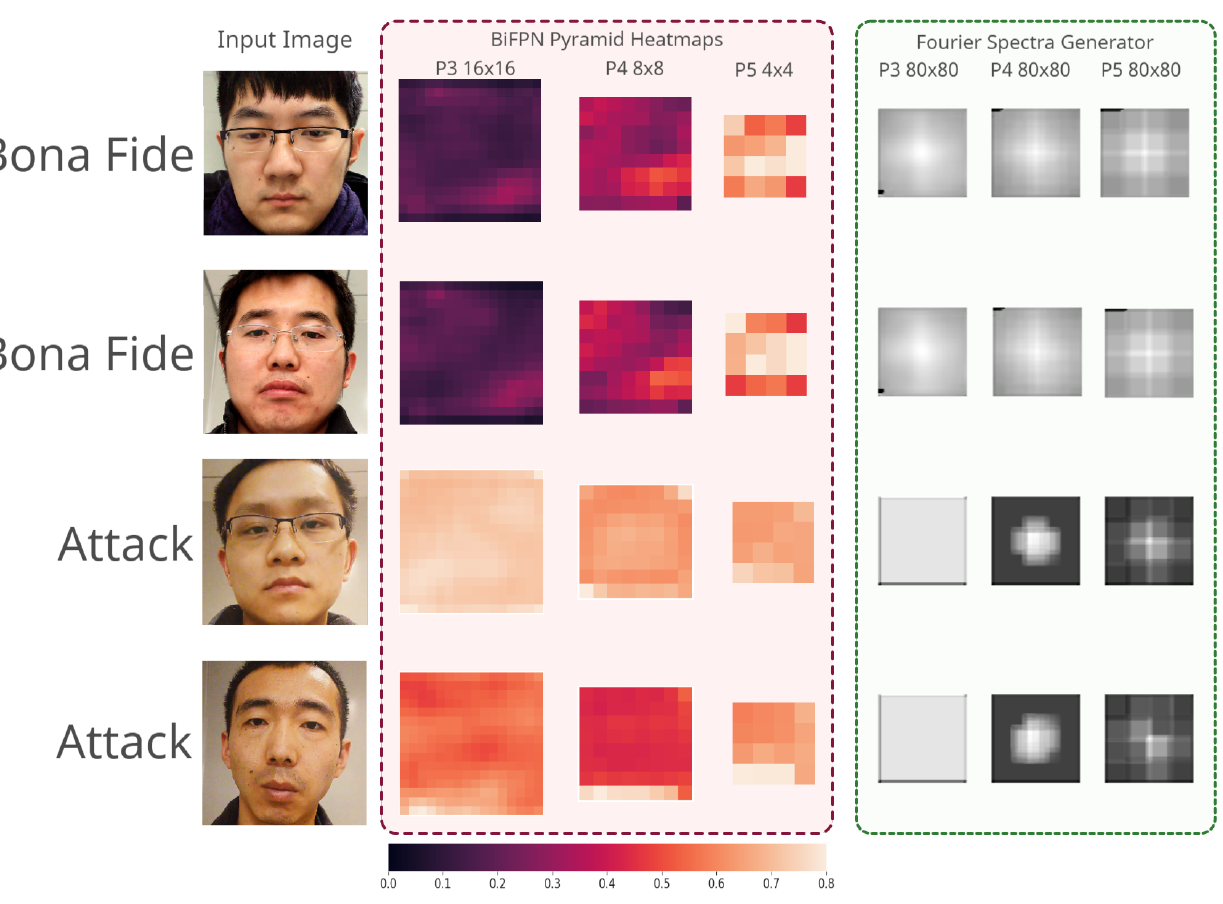
Figure 9. Heatmaps and Fourier spectra generated using three pyramids of the Bi-FAS-S model on four samples from the OULU-NPU [14]